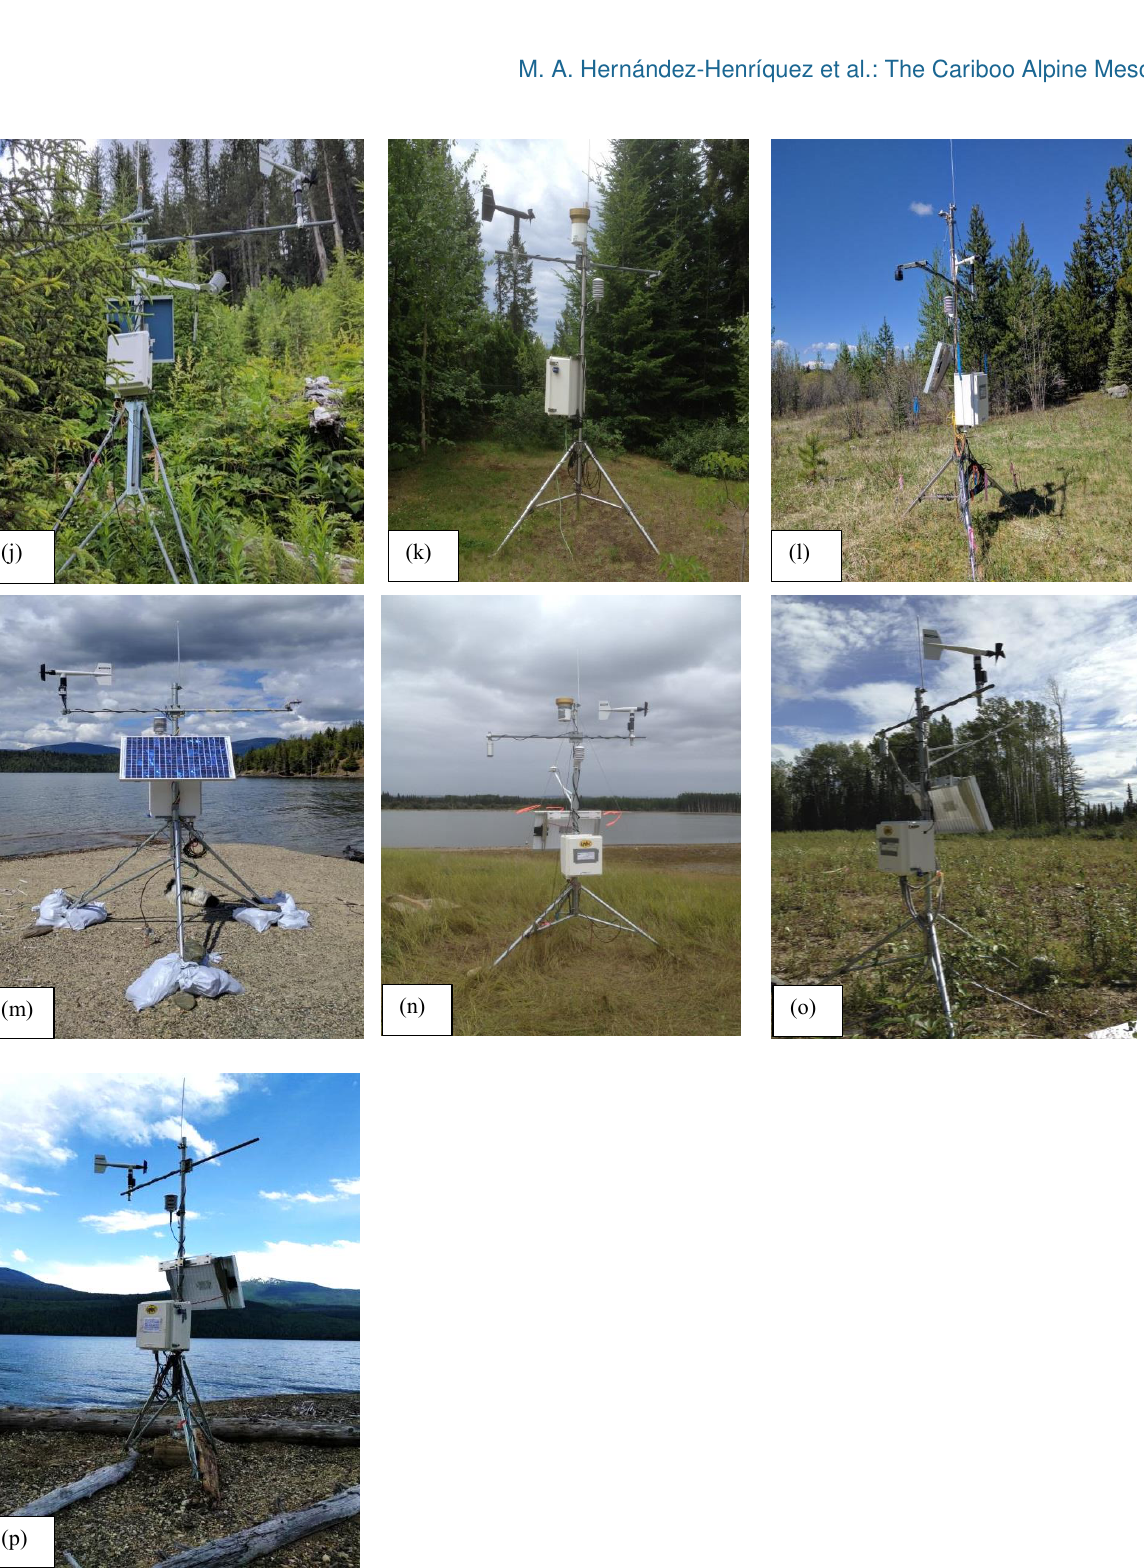
Figure 4. Photos of CAMnet weather stations: (a) QRRC in May 2017 (el. 743m), (b) Spanish Mountain in June 2017 (el. 1509m), (c) Blackbear Mountain radio repeater in July 2015 (el. 1509m), (d) Browntop Mountain in June 2017 (el. 2030m), (e) Upper Castle Creek Glacier in September 2015 (el. 2105m), (f) Mount Tom in September 2008 (el. 1490m), (g) Lower Castle Creek Glacier in September 2015 (el. 1803m), (h) Castle Creek Glacier radio repeater in August 2009 (el. 2219m), (i) Ancient Forest in May 2017 (el. 774m), (j) Lunate Creek in June 2017 (el. 953m), (k) Ness Lake in June 2015 (el. 763m), (l) Tatuk Lake in May 2017 (el. 938m), (m) Plato Point in May 2017 (el. 728), (n) Kiskatinaw in August 2015 (el. 726m), (o) Coles Lake in July 2015 (el. 479m) and (p) Long Creek in June 2017 (el. 728m). Earth Syst. Sci. Data, 10, 1655–1672, 2018